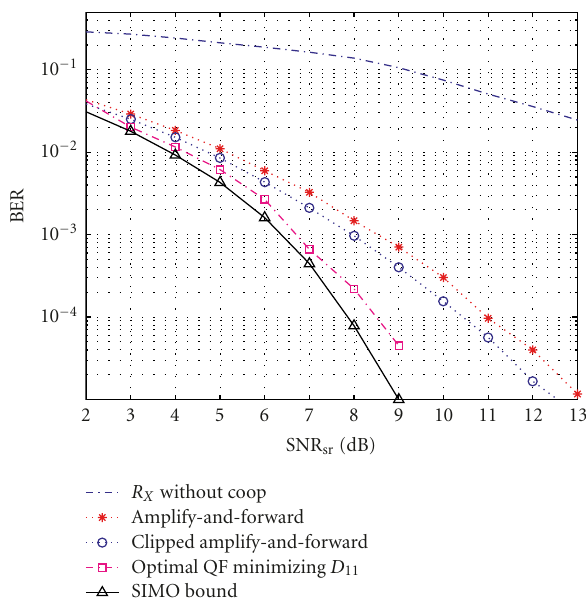
Figure 6: Comparison of the di ff erent relaying schemes (AF, clipped AF, optimum QF with b = 6) in static channels for SNR sr = SNR sd + 10dB with SNR rd = 10dB.